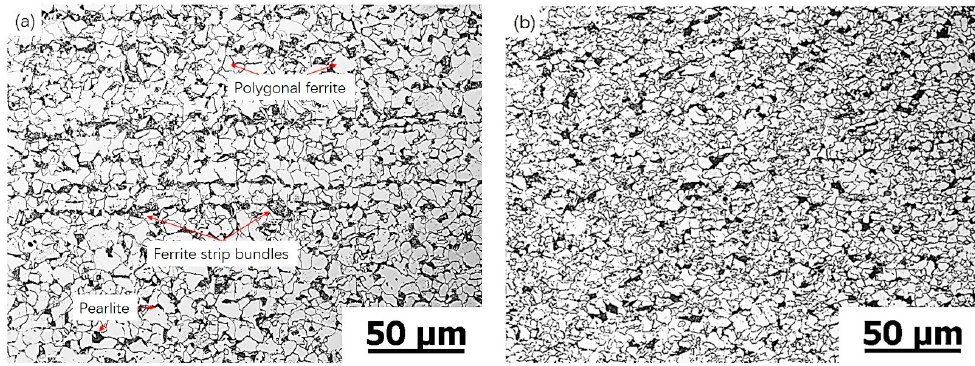
Figure 3. Rolling microstructure of testing steel: ( a ) with V; and ( b ) with Nb. The HAZ microstructures after welding are shown in Figure 4. The test steel with V had granular bainite, pearlite, and ferrite in the coarse austenite grains, whereas the test steel with Nb had considerably smaller grains in the HAZ.